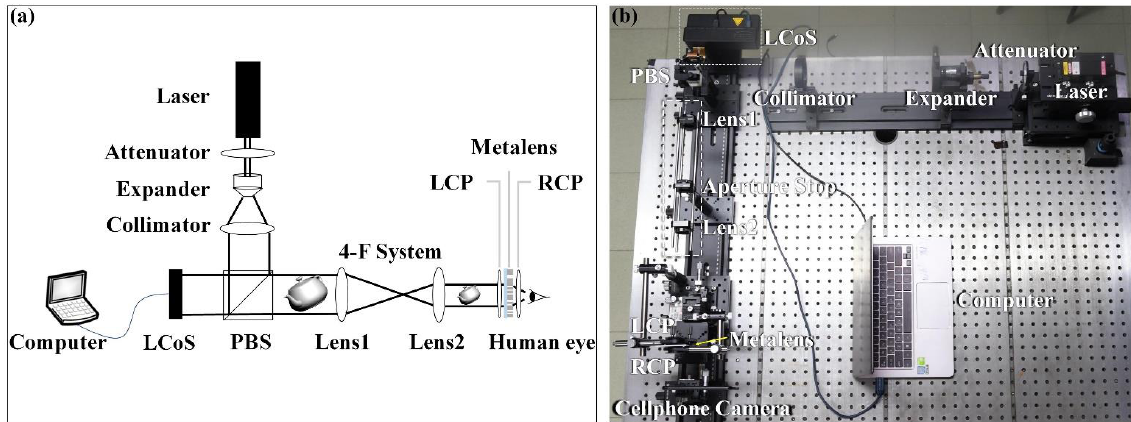
Figure 6. ( a ) Schematic of the MCGH-NED experimental setup. ( b ) Photograph of the MCGH-NED experimental setup. As for the problem of zero-order light, the digital blazed grating is introduced in the hologram. It can be expressed as φ bg ( x , y ) = (2 π / T ) ∙ mod( cx + dy , T ), where T is the period of digital blazed grating, and c and d are two constants related to the shift distance in x and y directions, respectively. For this system, c as well as d are 0 and 1, and T is 1.5 times the sampling interval of the hologram. After the modulation of digital blazed grating, the HRI can be separated from zero-order light, which can be eliminated by the pinhole at the confocal position of the 4-F system for suppressing noise. Ultimately, the transferred 3D HRI is positioned within the focal length of the metalens, and an LCP polarizer is placed between it and the metalens eyepiece, which can focus LCP incidence and output focused RCP light. Having been modulated by the metalens, the output light passes through an RCP polarizer for filtering the desired virtual image and realizing the VR display. The floated virtual image is then viewed by the human eye and captured by an iPhone 6 cell- phone camera. Figure 7 above shows the experimental results of a 3D holographic near-eye display with the designed metalens as an eyepiece. Figure 7a is the original layered model of ZJU. Three sub-holograms are calculated from Z, J, and U, respectively, with different propa- gation distances, and the propagation distance interval is set at 100 mm. The images are